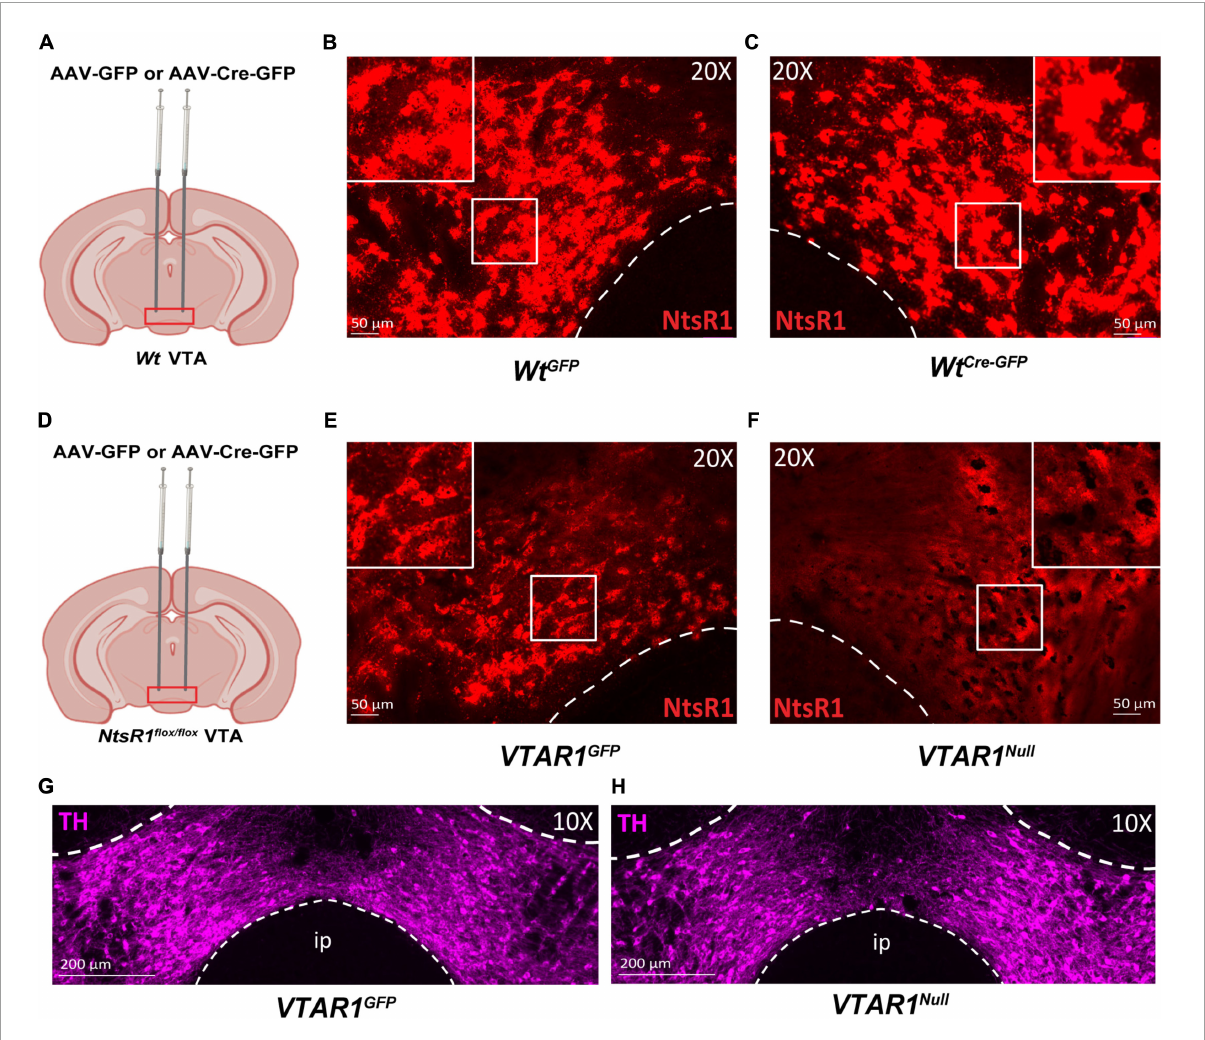
FIGURE6 Injection of AAV-Cre-GFP deletes NtsR1 from DA neurons of adult NtsR1 flox / flox mice. (A–F) Adult Wt mice or NtsR1 flox / flox mice were injected bilaterally in the VTA with either AAV-GFP or AAV-Cre-GFP. VTA tissue from perfused mice was assessed for Ntsr1 mRNA expression (red) by RNAScope assay. Wt mice injected with (B) AAV-GFP and (C) AAV-Cre-GFP have comparable distribution of Ntsr1 in the VTA. (D) NtsR1 flox / flox mice injected in the VTA with (E) AAV-GFP have intact Ntsr1 mRNA expression but (F) it is absent in the VTA of AAV-Cre-GFP injected mice. Distribution of tyrosine hydroxylase (TH, magenta) protein via immunofluorescence in (G) AAV-GFP injected NtsR1 flox / flox mice, referred to as VTAR1 GFP , and AAV-Cre-GFP injected NtsR1 flox / flox mice, referred to as VTAR1 Null mice. Images are representative of n = 3 mice per genotype and injection. Scale bars = 50 µ m, 200 µ